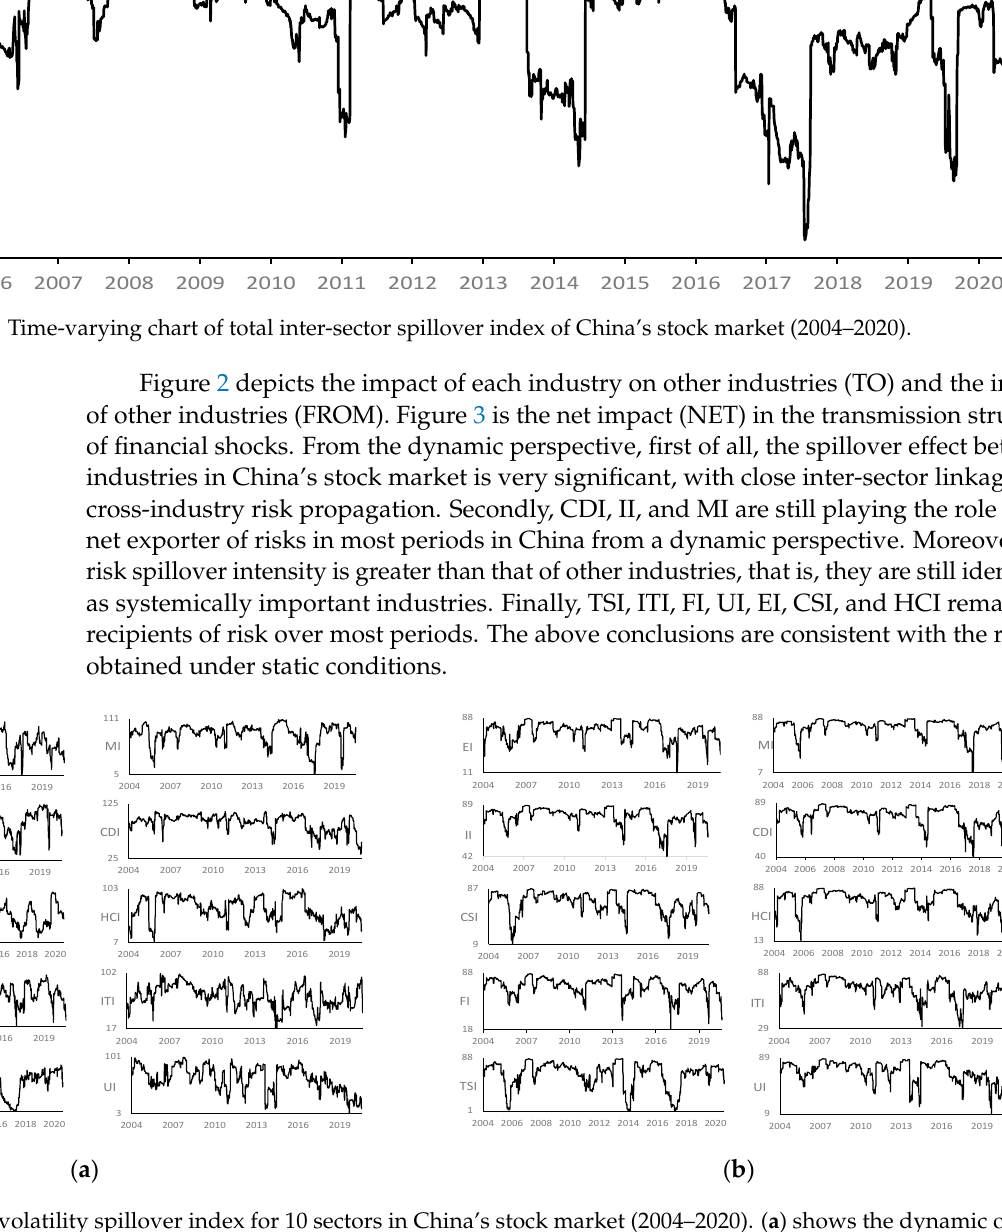
Figure 3. “Net” spillover index for 10 sectors in China’s stock market (2004–2020). According to Figures 2 and 3, the influence of each industry on and by other indus- tries is constantly changing over time, and so is the net impact. In general, the trend of TO index and FROM index of all industries is similar, but the maximum value of three sys- temically important industries, namely MI, II, and CDI, is much higher than that of other sectors. The minimum value of the TO index of II is also much higher than others. The FROM indexes of II and CDI industries are significantly different from those of the other eight industries. The variation ranges of the two sectors’ FROM indexes are relatively con- centrated, which are almost half of that of other industries which range between 40–90%. This indicates that these two industries are always concentrated at a high level under the influence of other industries. By contrast, NET indexes of different sectors appear to be very distinct. Table 5 re- flects the change of the roles of the ten industries in the entire sample interval according to the NET indexes. When the Net index of this industry is greater than zero, it is consid- ered to be a risk transmitter in the whole system. Otherwise, it is considered a risk ab- sorber. As can be seen intuitively in Figure 3, the recognized net indexes of MI, II, and CDI